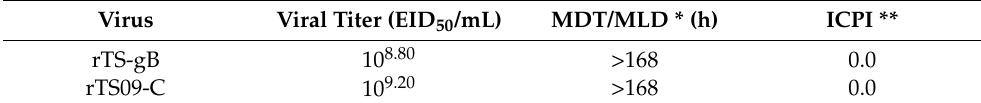
Table 1. Biological characteristics of the recombinant viruses.